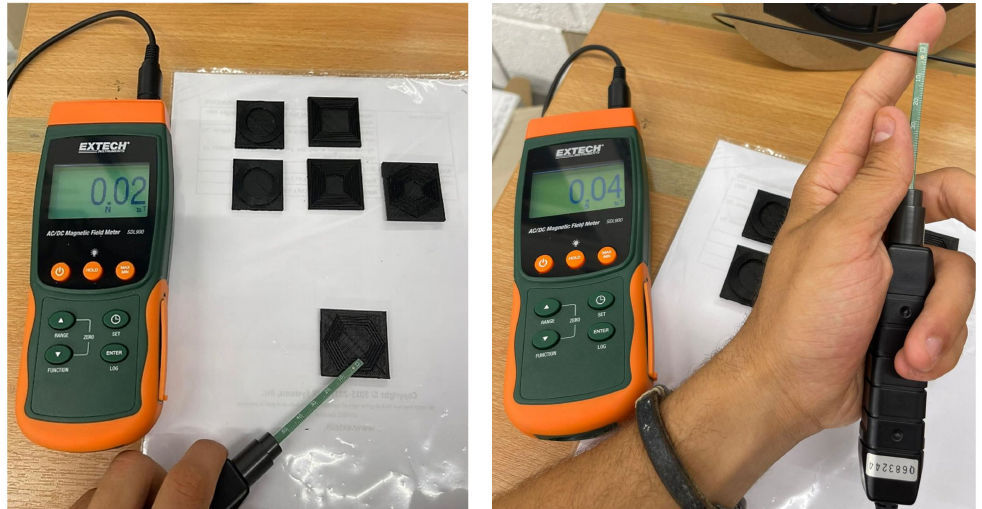
Figure 9. Magnetic strength measurement on the conductive filament (prior to the printing) and RFID coils (post